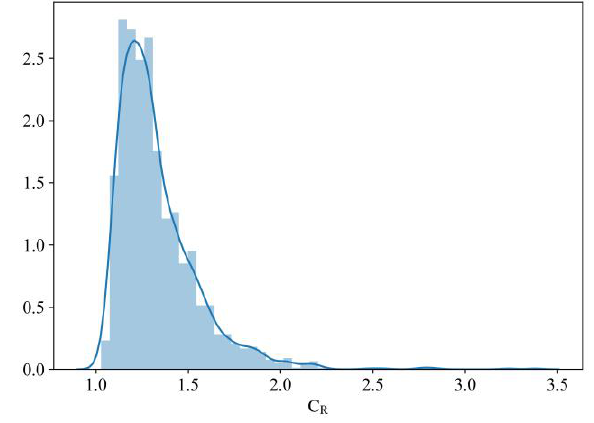
Figure 11. Distribution plot of C R obtained by JPEG-LS